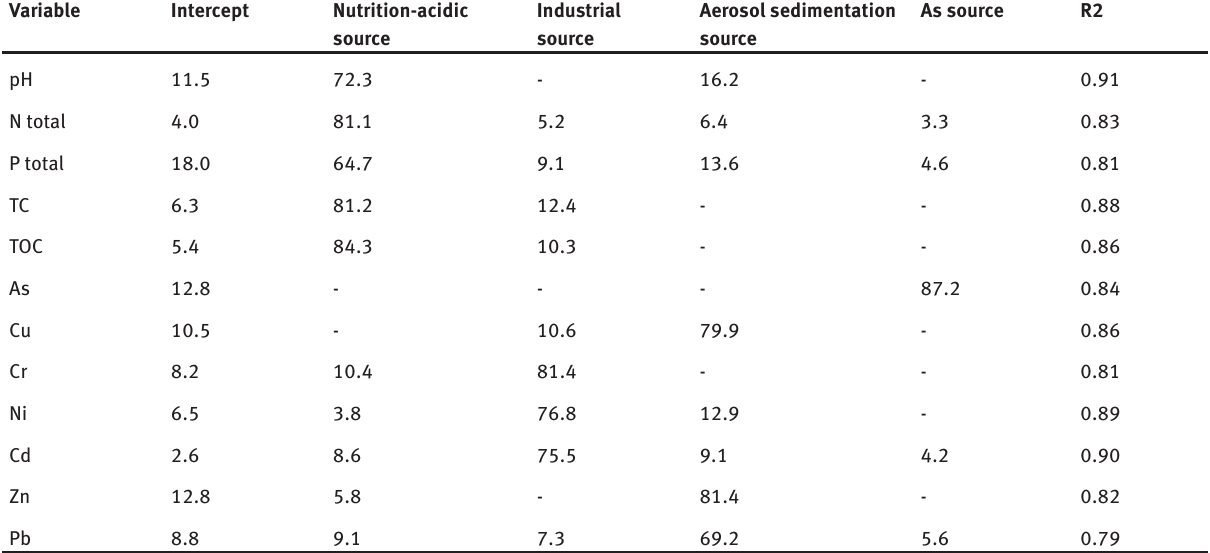
Table 4: Source apportionment for the soil quality parameters in region of Burgas, Bulgaria (in %).